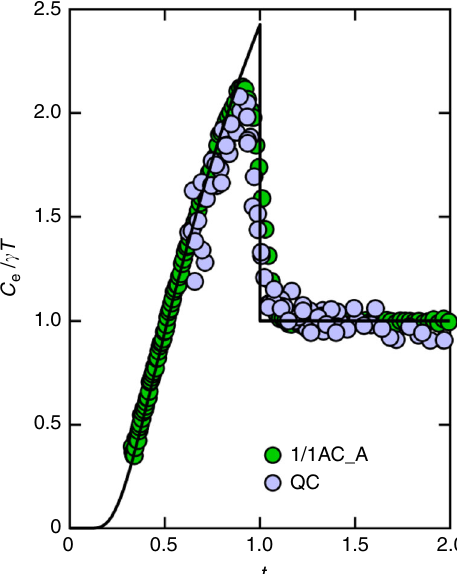
Fig. 8 Speci fi c heat around superconducting transition. Normalized speci fi c heat divided by temperature as a function of the reduced temperature t ¼ T = T c for the QC (with T (cid:11) 0 : 05 K) and the 1/1AC_A ( T (cid:11) 0 : 8 K). c c Here, C e is the electronic part of the speci fi c heat. The solid line denotes the weak-coupling BCS theory. Note that both results of the QC and